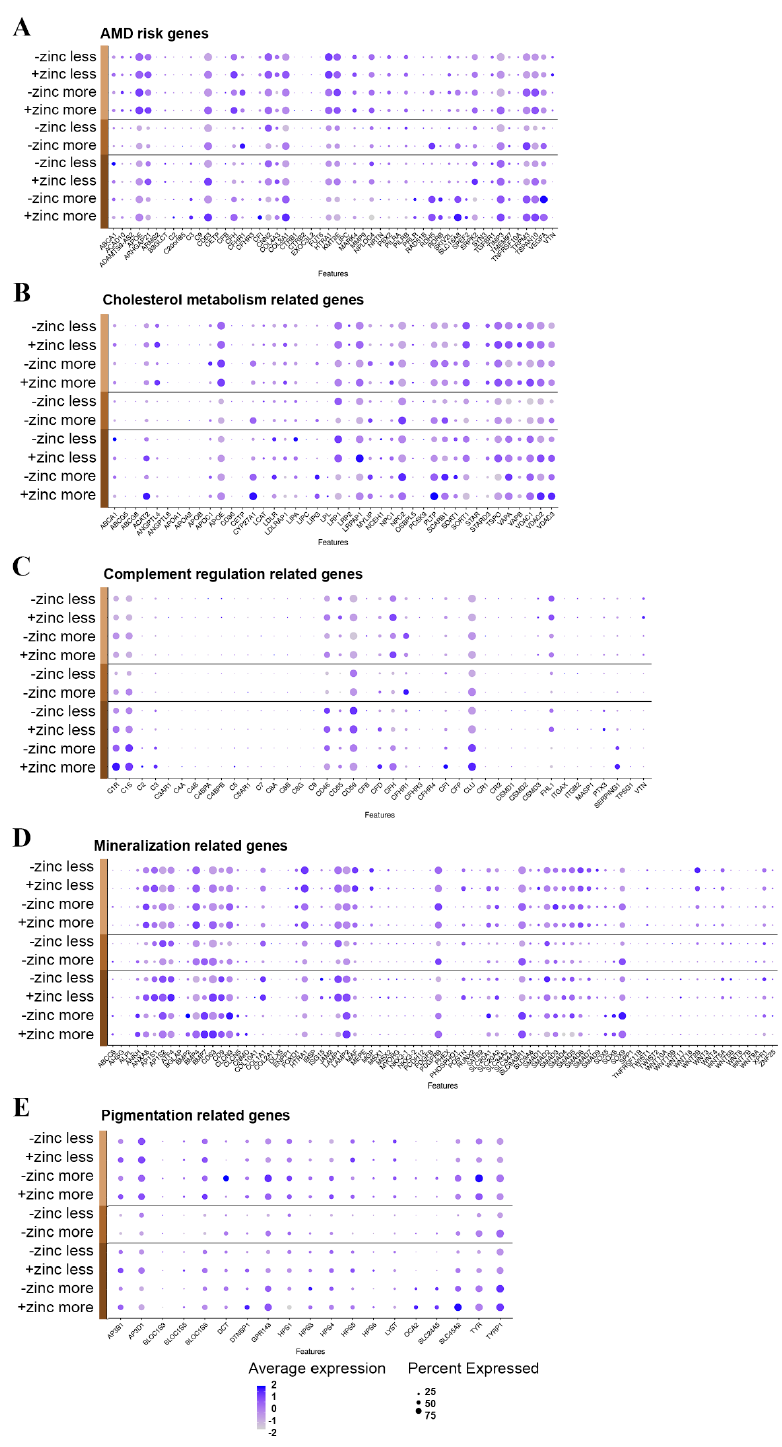
Figure 5. Distribution of age-related gene expression in RPE over time in vitro. AMD risk genes ( A ), cholesterol-metabolism-related genes ( B ), complement-regulation-related genes ( C ), mineralization- related genes ( D ), and pigmentation-related genes ( E ). Light brown represents 2 weeks, medium brown represents 9 weeks, dark brown represents 19 weeks in